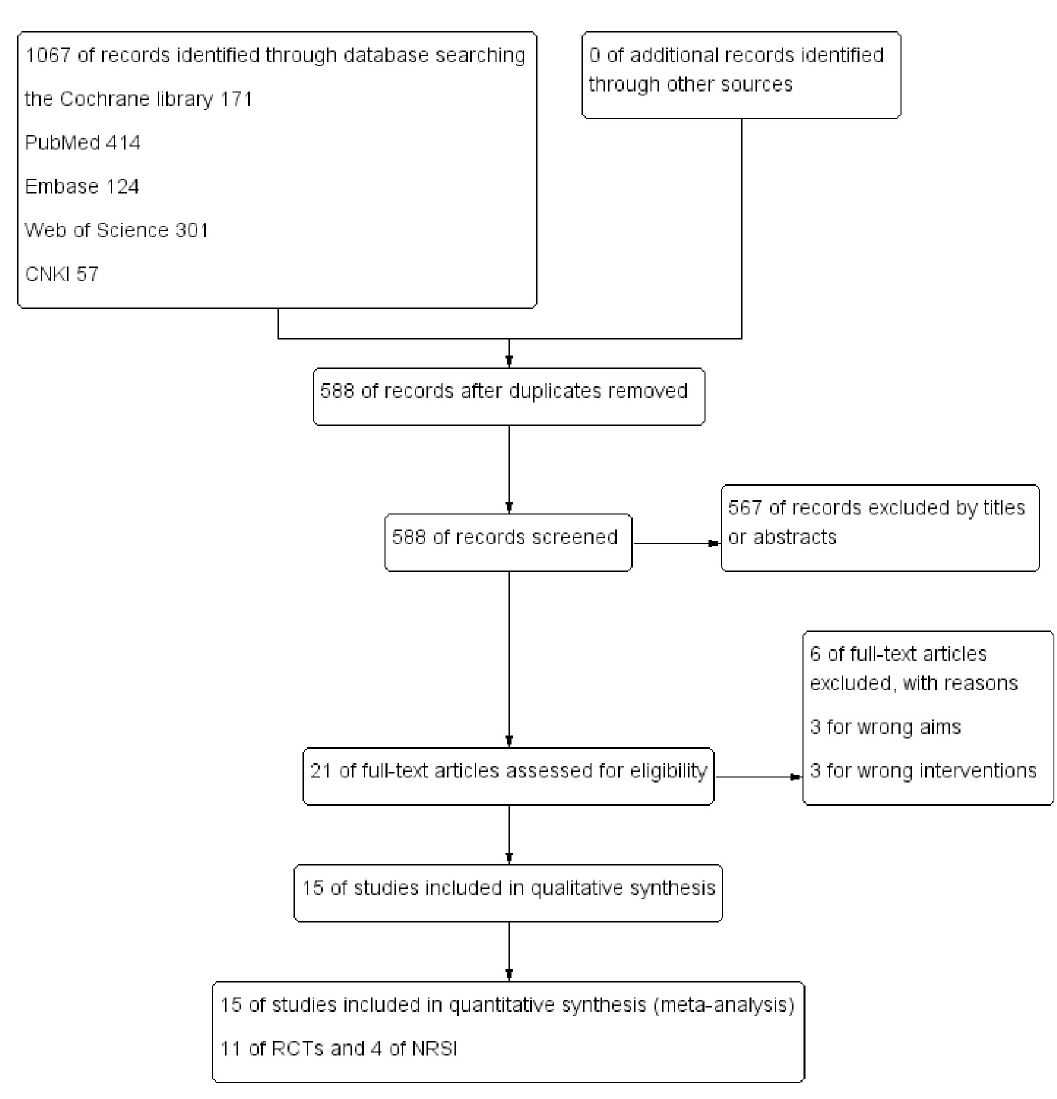
Fig 1. Flow diagram of literature search and selection of included studies for